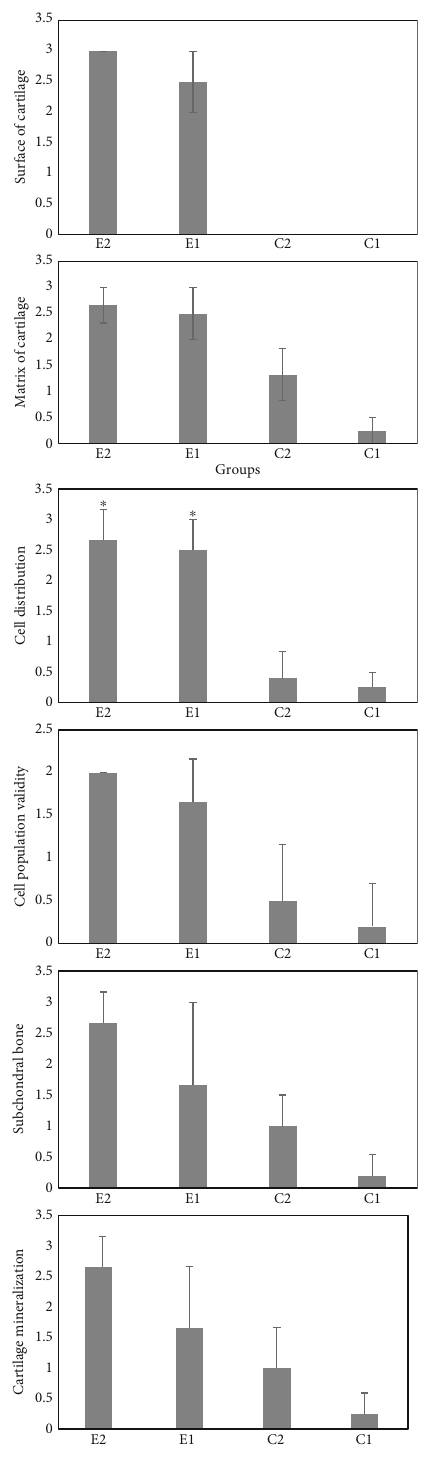
Figure 1: Histological scores of OA in rat models including E2 group: synovial membrane-based stem cell, E1 group: adipose tissue-derived stem cells, C2 group: Hyalgan-treated, and C1 group: nontreated group, based on International Cartilage Repair Society (ICRS). Values are shown as the median and interquartile range. ∗ p value < 0.05 vs. C1.